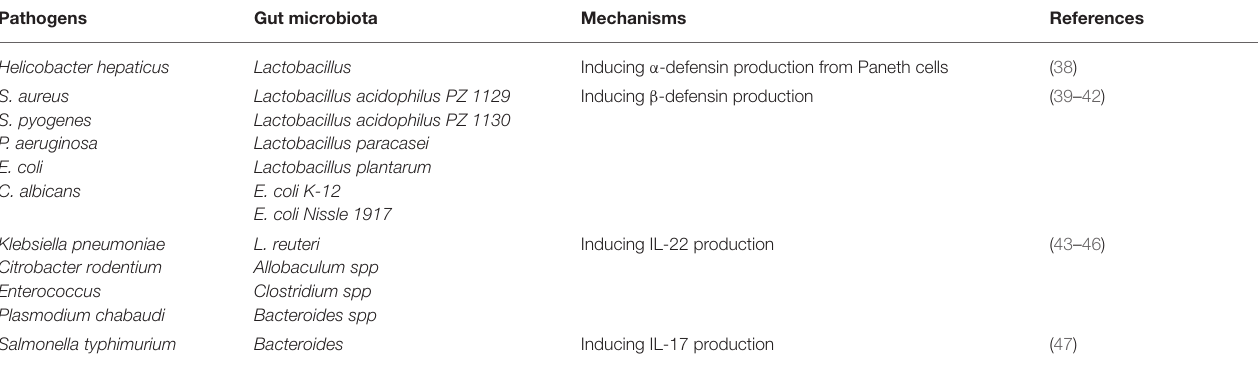
TABLE 1 | Gut microbiota protects the host against pathogen infections and the relevant mechanisms.